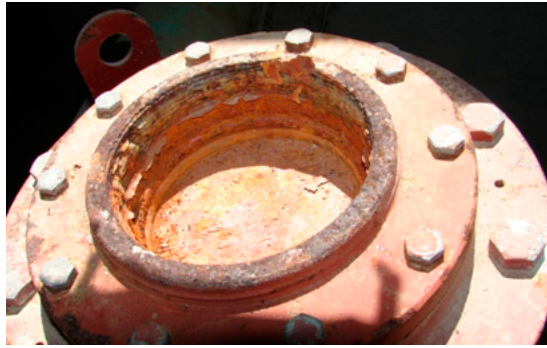
Figure 5. Damage air valve at station 0 + 990.42.